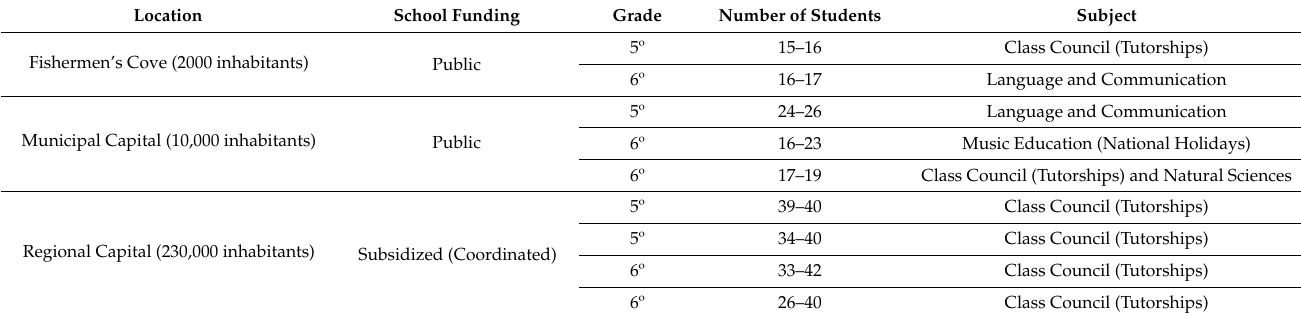
Table 1. Distribution of observed